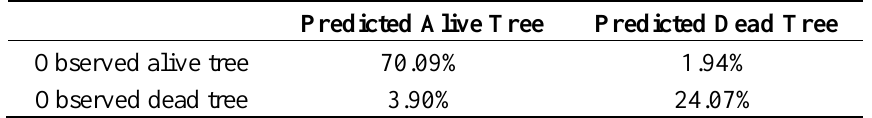
Table 15. Mean validation percentage using the parameters values selected for the light curtain calibration and validation